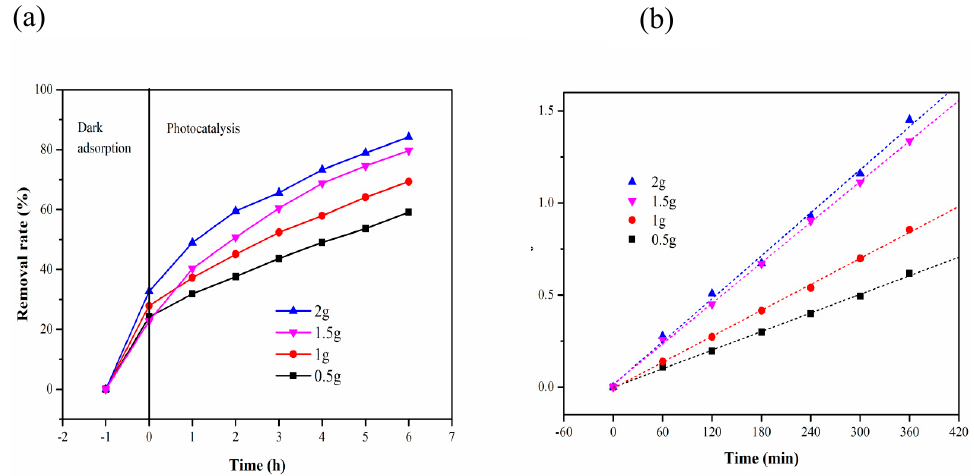
Figure 9. ( a ) Removal rate of MB under di ff erent dosages; ( b ) kinetics of photocatalytic degradation of MB with di ff erent dosages of the composite